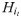
Best fit of models (1)–(3) to reported dengue cases in Bello.The real data corresponds to the number of reported cases for the dengue outbreak occurred in Bello in 2010. We present here two different visualizations to assess the fit of the three models to the data: in the figure to the left we show the fit to the synthetic model state we added (Hit), that represents the cumulative number of reported Dengue cases. On the other hand, for the figure in right, we transform the data into cumulative Dengue cases per week, which is a friendly way to visualize the process. We fit the model to the cumulative number of Dengue cases, but we reported the MSE cost function for both of the visualizations as follows: MSE = (value for figure in right- value for figure in left). Cost functions (MSE): model (1) = (75.32-699.49), model (2) = (73.86-658.1), model (3) = (73.22-642.63).